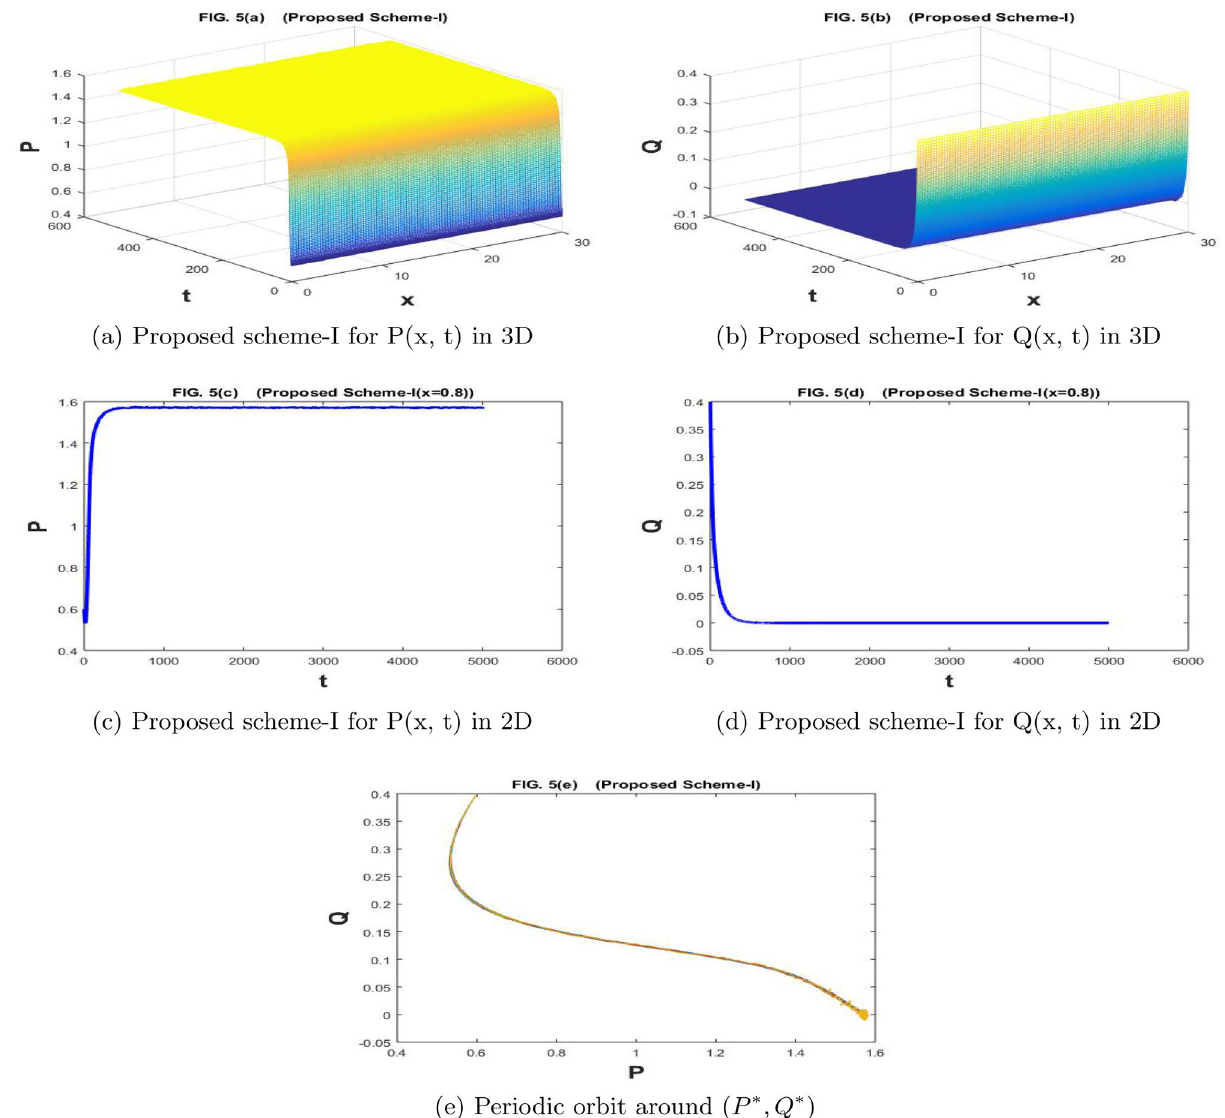
Figure 5. The subfig ( a and c ) and ( b and d ) represents the numerical approximation of P ( x , t ), and Q ( x , t ) respectively by proposed scheme-I. The subfig ( e ) represents the periodic orbit around ( P ∗ , Q ∗ )